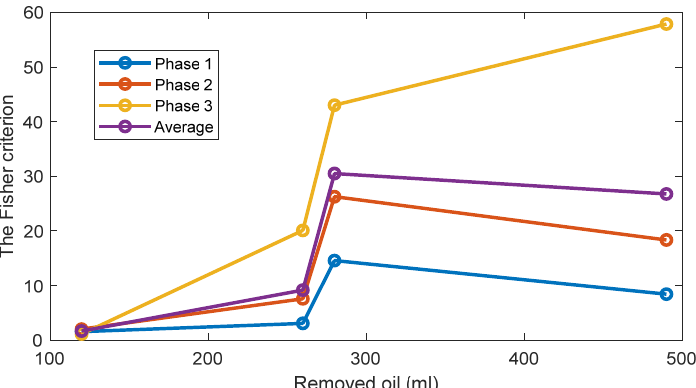
Figure 12. The FC of Feature 2 for three phases and 4 levels of oil removal compared to the standard oil level for Day 1.